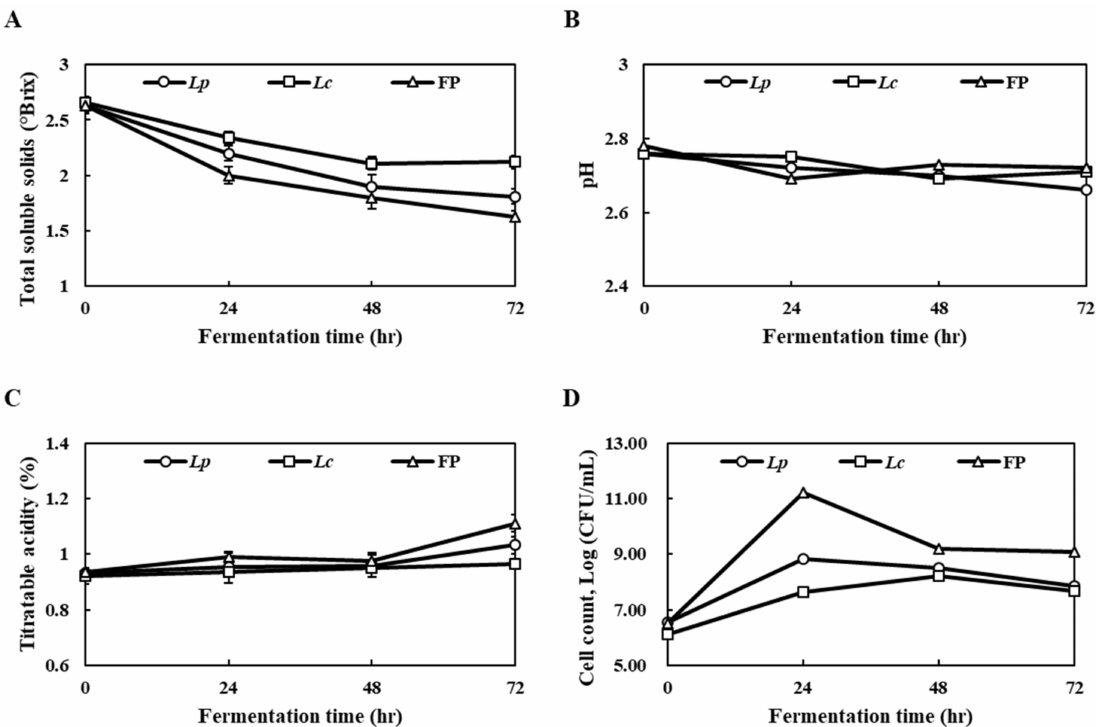
Figure 2. Changes of the physicochemical properties; ( A ) total soluble solids, ( B ) pH, ( C ) titratable acidity and ( D ) viable Lactobacillus count in Prunus mume juice during fermentation with mono- and mixed cultures of L. plantarum and L. casei. Lp, fermented Prunus mume juice with L. plantarum ; Lc , fermented Prunus mume juice with L. casei ; FP, fermented Prunus mume juice with L. plantarum and L. casei . Data are mean ± S.D. of three independent